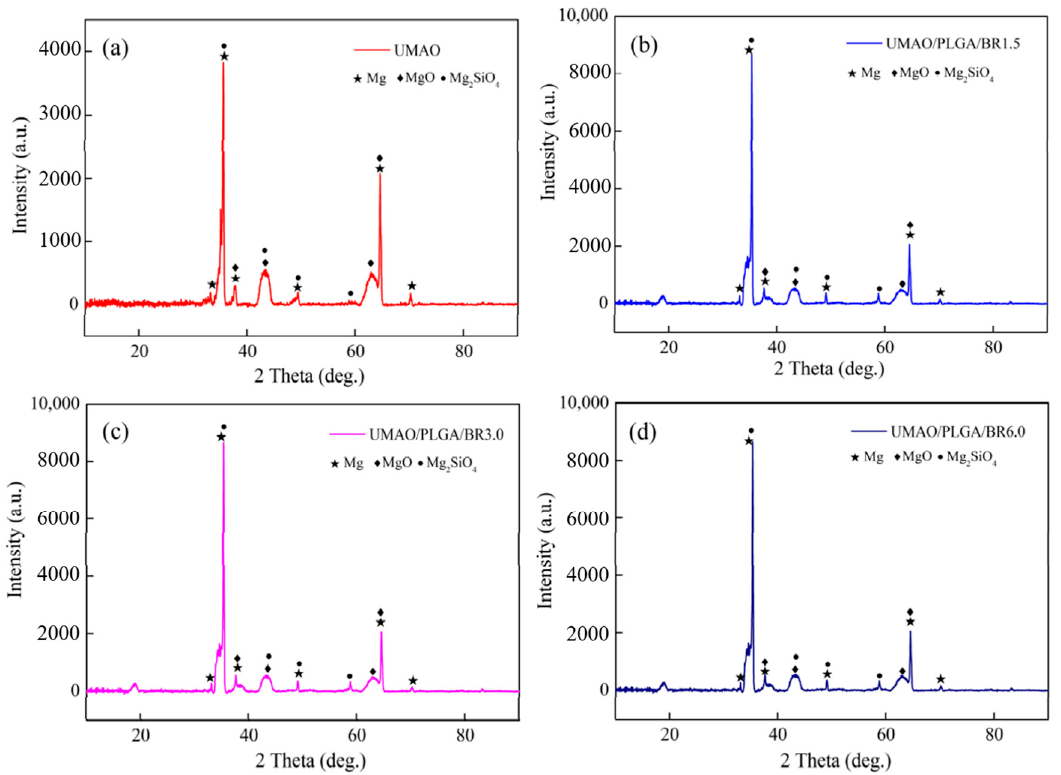
Figure 3. X-ray di ff raction (XRD) patterns of coatings with various BR contents: ( a ) UMAO; Figure 3. X-ray diffraction (XRD) patterns of coatings with various BR contents: ( a ) UMAO; ( b ) ( b ) UMAO / PLGA / BR1.5; ( c ) UMAO / PLGA / BR3.0; ( d ) UMAO / PLGA / UMAO/PLGA/BR1.5; ( c ) UMAO/PLGA/BR3.0; ( d ) UMAO/PLGA/BR6.0.